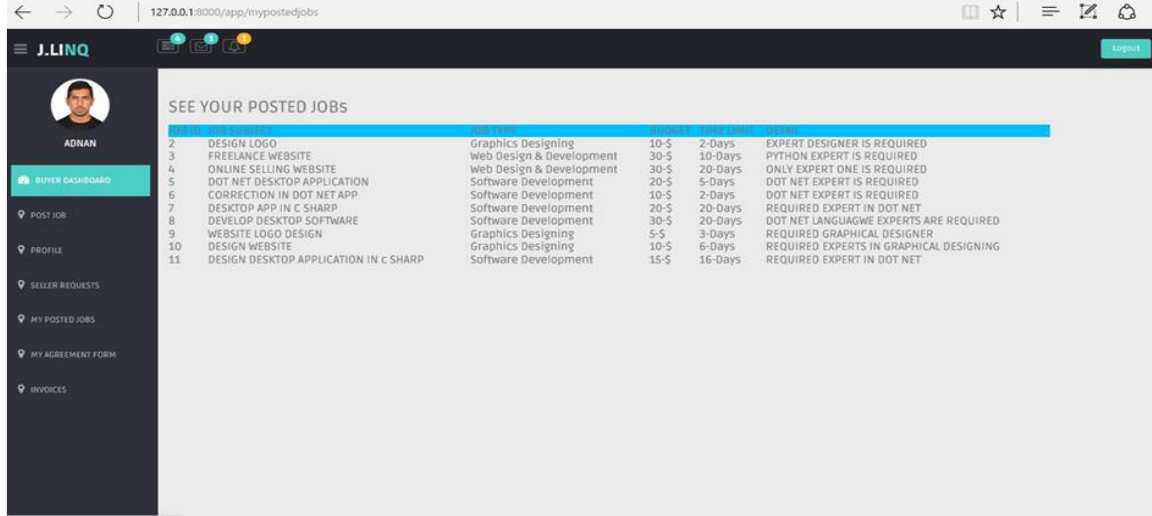
Figure 14. List of the posted job by the same buyer in the platform.